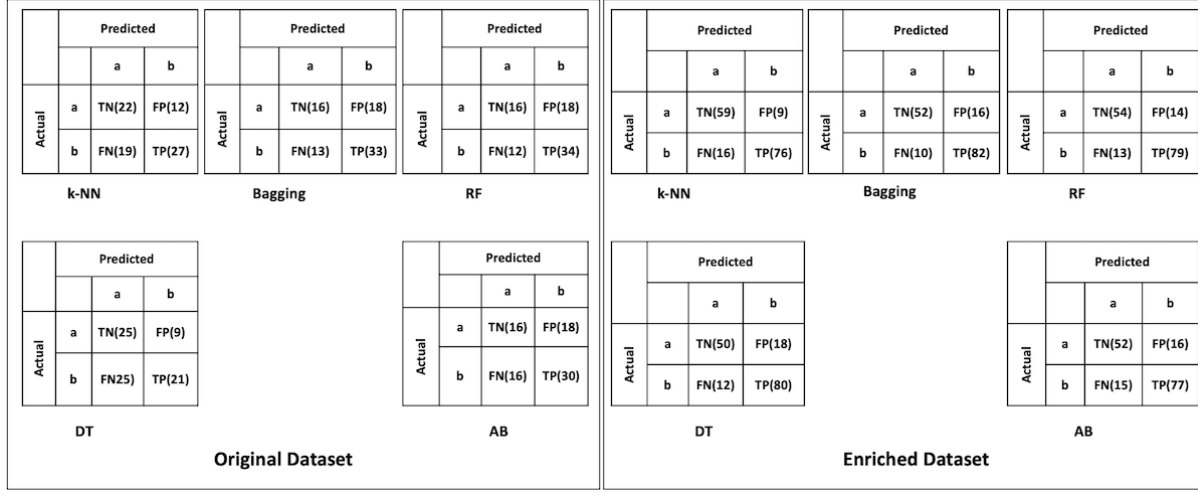
Table 2. Precision, recall, and F-measure of the models trained with original data.